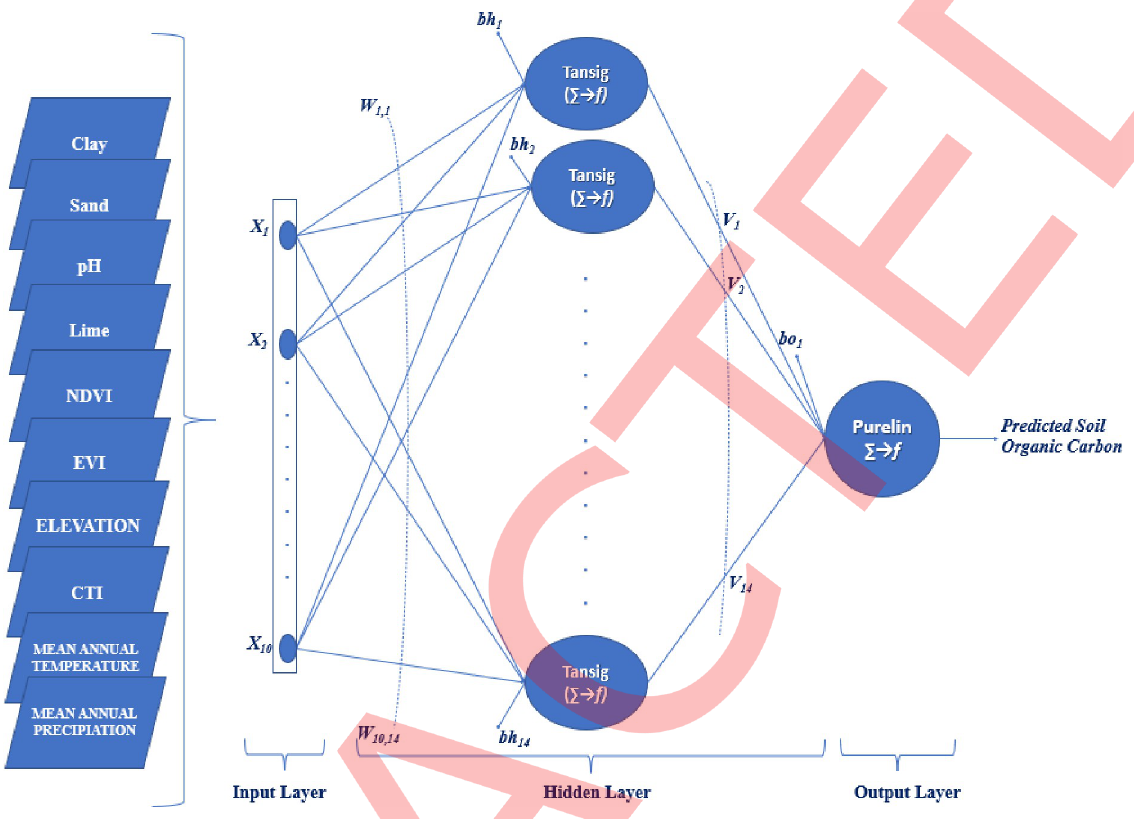
Fig 2. The structure of the ANN model used in the study. ’tansig’ tangent sigmoid function; ’purelin’ represents the linear transfer function.